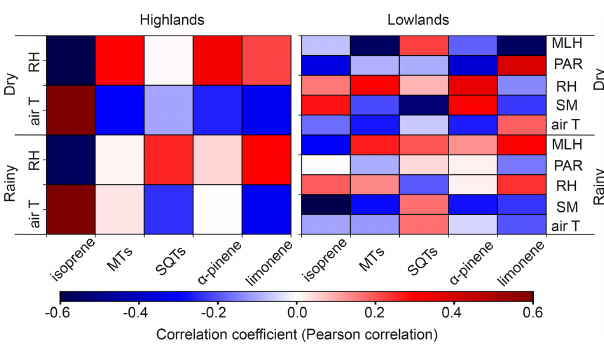
Figure A4. Correlation coefficients between BVOCs and environ- mental